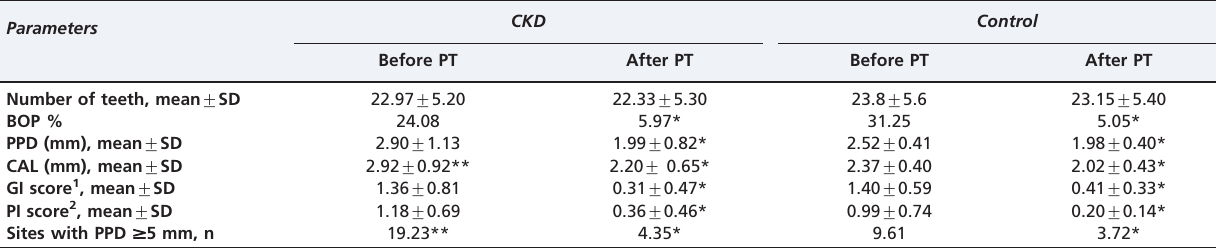
Table 2 - Periodontal parameters at baseline and 3 months after periodontal treatment. Parameters CKD Control Before PT After PT Before PT After PT Number of teeth, mean ¡